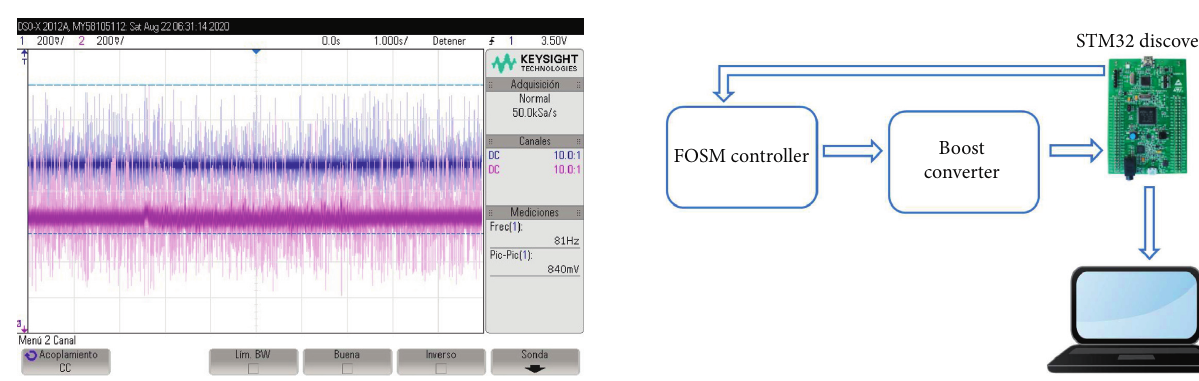
Figure 20: Boost converter prototype scheme for the FOSM controller.